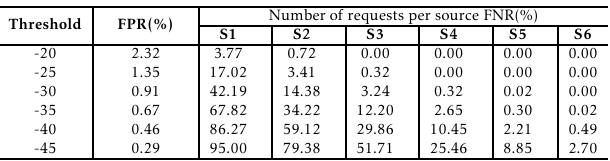
Table 6. Experimental results for the Markov chain model for the attack strategy of focusing on high number of requests.